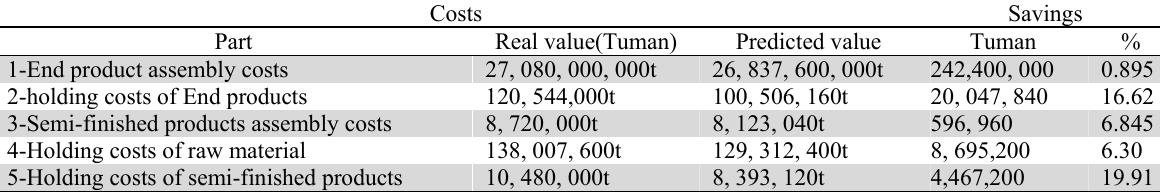
Costs and Savings (Peugeot